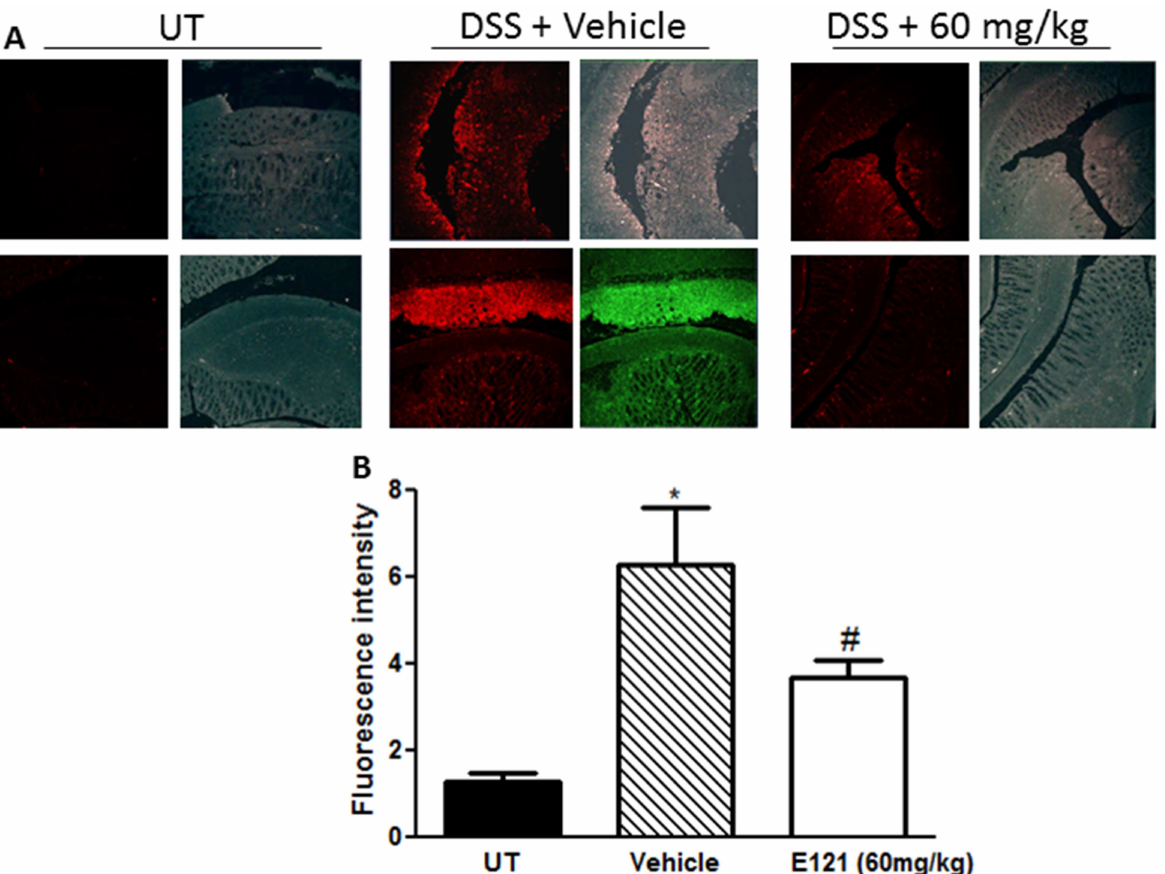
Fig 6. Effect of E121 on neutrophil recruitment in vivo . Colon sections taken from untreated(UT) mice or mice treated with DSS plus E121 (60 mg/kg) or vehiclewere immunostained with antiseraagainst the neutrophilmarker Gr1 (panelA). Immunofluorescent (Alexa Fluor) signalsshown in left side of panel A are overlaid with DAPI stain on right side to show tissue architecture for the conditions indicated. Panels B representquantitativeassessment of fluorescence intensity (arbitrary units). Histobars represent means ± SEM for 6 mice in each group. Asterisk denotes significantdifference from UT mice, with p < 0.05,and # denotessignificantdifference from DSS/ i.p vehicletreated mice, with p <